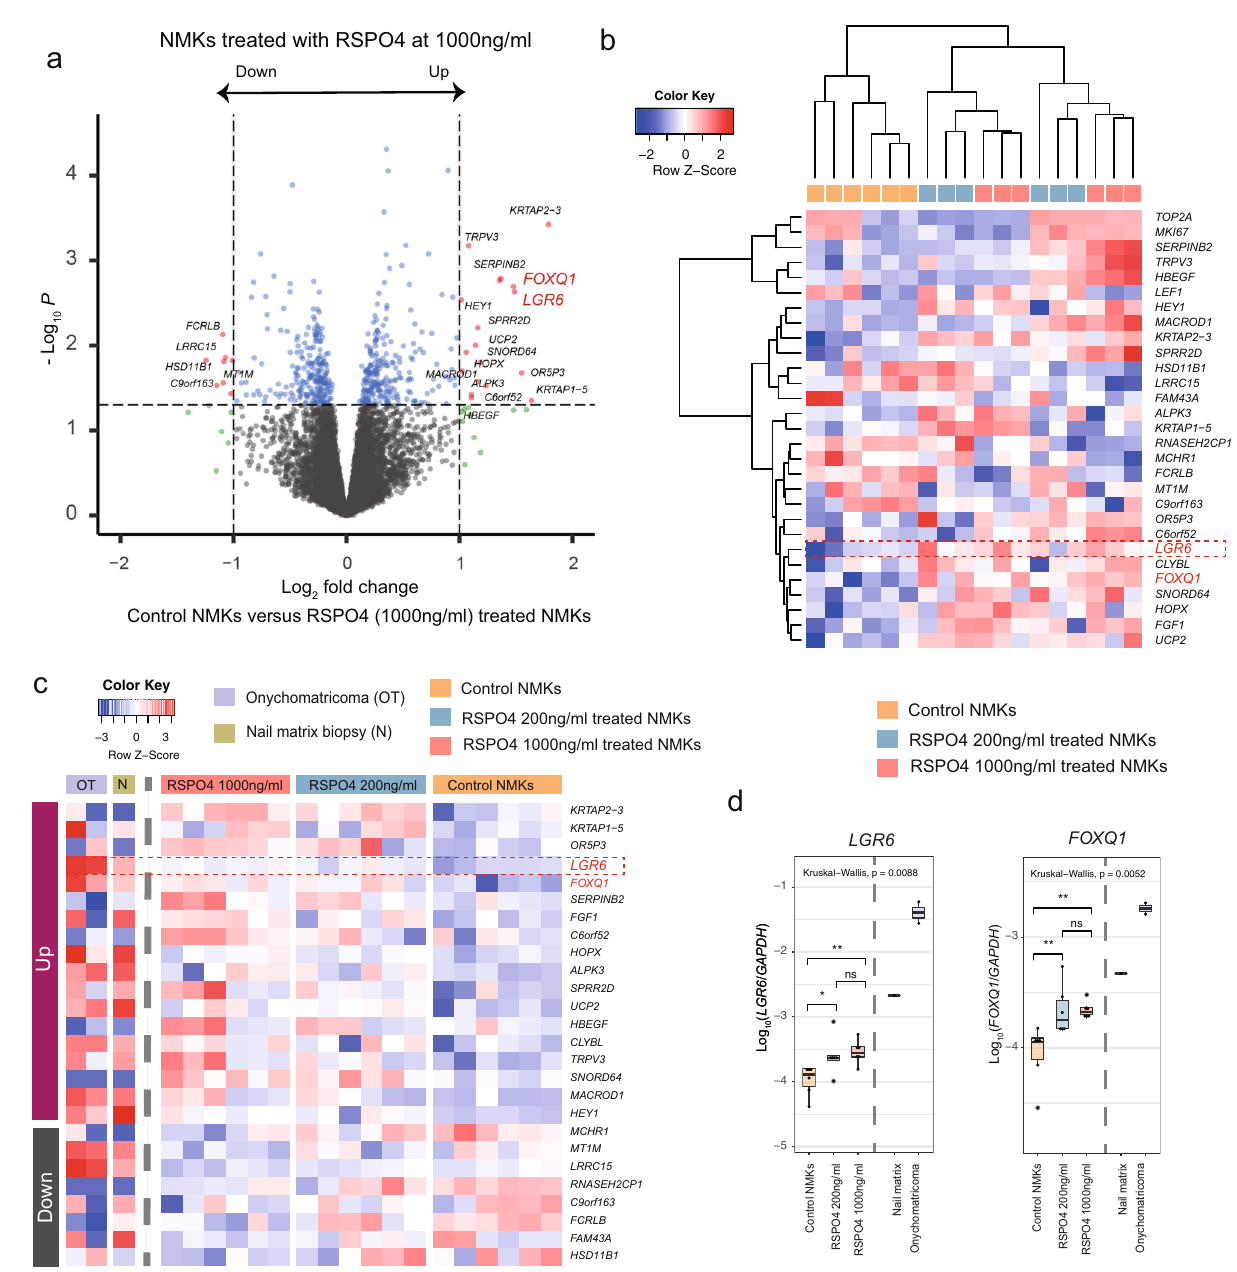
Fig. 6 RSPO4 regulated epithelial LGR6 expression in nail matrix keratinocytes (NMKs). a Volcano plot depicting differentially expressed genes (DEGs) for RSPO4 (1000 ng/ml) treated and control NMKs. A total of 26 DEGs were identi fi ed, including LGR6 and FOXQ1 . b Heatmap of DEGs, as determined in Fig. 6a. DEGs de fi ned by P value < 0.05 and fold change >2 cutoffs. LEF1 , MKI67 , and TOP2A were also used for the heatmap. The 6 replicates RSPO4 1000 ng/ml treated, 6 replicates RSPO4 200 ng/ml treated, and 6 control NMKs were used for hierarchical clustering. WNT signaling-associated genes are shown in red. c Heatmap showing mRNA expression ( Z score) of the upregulated and downregulated genes, as determined in Fig. 6a. The two onychomatricoma and one nail matrix biopsy sample were also used for analysis. d Boxplots of WNT signaling associated gene expression (log 10 value of mRNA expression relative to GAPDH expression) under the indicated culture condition. The onychomatricoma and nail matrix biopsy samples were also included. Mann – Whitney U test was used to assess statistical signi fi cance. ∗ P < 0.05; ∗∗ P < 0.01; ns not signi fi cant. NMKs nail matrix keratinocytes, DEGs differentially expressed